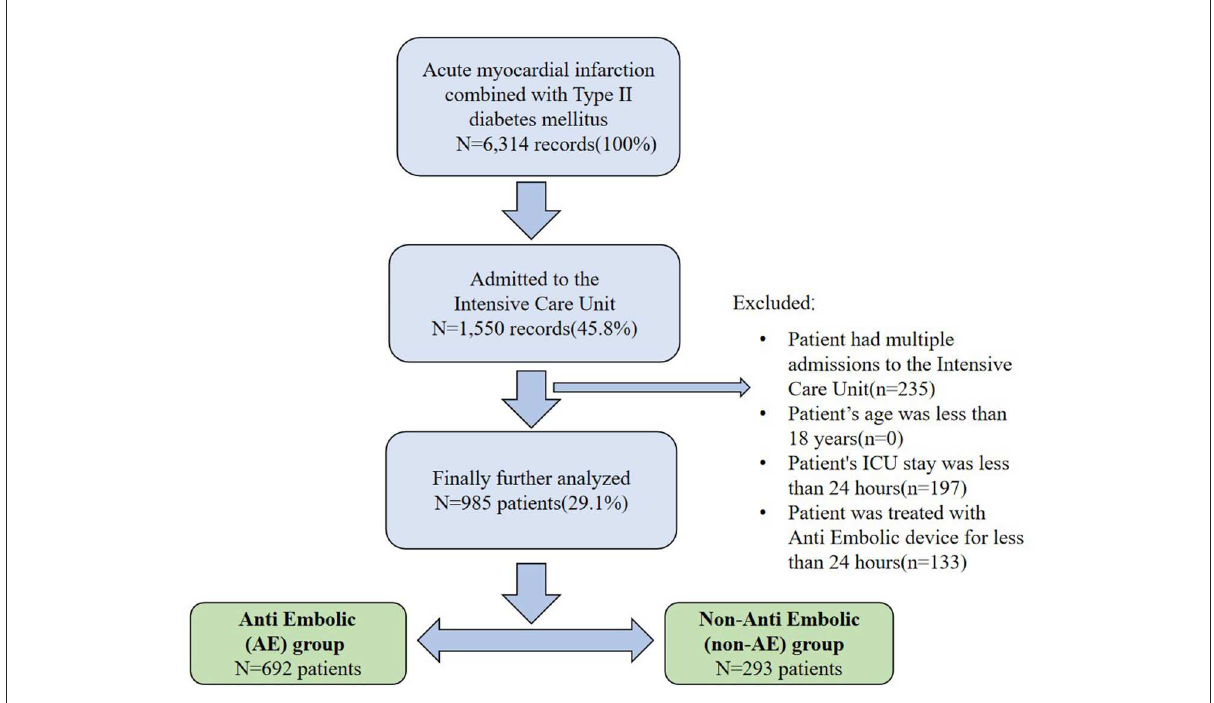
FIGURE1 Flowchart of study population